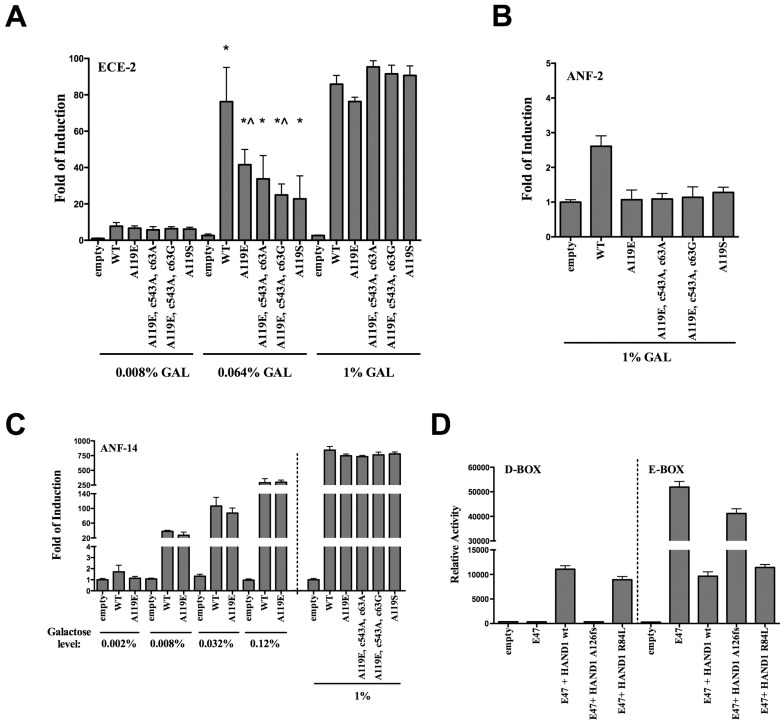
Transactivation potential of the p.A119E and p.A119S NKX2-5 mutations.Presented in A-C is the average fold of luciferase reporter induction, relative to the activity measured at the lower galactose concentration in the absence of NKX2-5 proteins. Error bars correspond to the standard deviation of at least three biological repeats. Results were obtained with a reporter strain where the luciferase gene is controlled by a minimal promoter containing two repeats of the NK-RE derived from the ECE target gene (A), two repeats of the low-affinity NK-RE derived from the ANF target gene (B) or 14 repeats of the ANF NK-RE (C). The different NKX2-5 mutants and the galactose concentrations used to modulate expression are indicated. With the ECE reporter, the activity of p.A119E and p.A119S is significantly, albeit modestly reduced compared to wild type NKX2-5 (*  =  wt NKX2-5 compared to each mutant alleles; p<0.05; t-test). The haplotype found in patient #58LM [c.356A (p.A119E) + c. 543A (p.Q181) + c.63G (rs2277923)] further reduced transactivation (?  =  A119E mutant alone compared to patient #58LM haplotype; p<0.05; t-test). The reference (wild type) NKX2-5 NM_004387.2 used here as control has the haplotype [c.356C + c. 543G + c.63A]. (C) The p.A119E mutation alone was tested with the highly responsive ANF-14 reporter strain using 4 different levels of protein induction obtained using the indicated concentrations of galactose in the medium. The complete panel of alleles was examined at high expression levels. (D) The impact of the HAND1 p.R84L mutation was examined using D-box and E-box reporter strain in co-expression experiments with E47–see text for details- The average relative light units normalized for the optical density of the cultures (OD600nm) and the standard deviations of 4 replicates are presented.